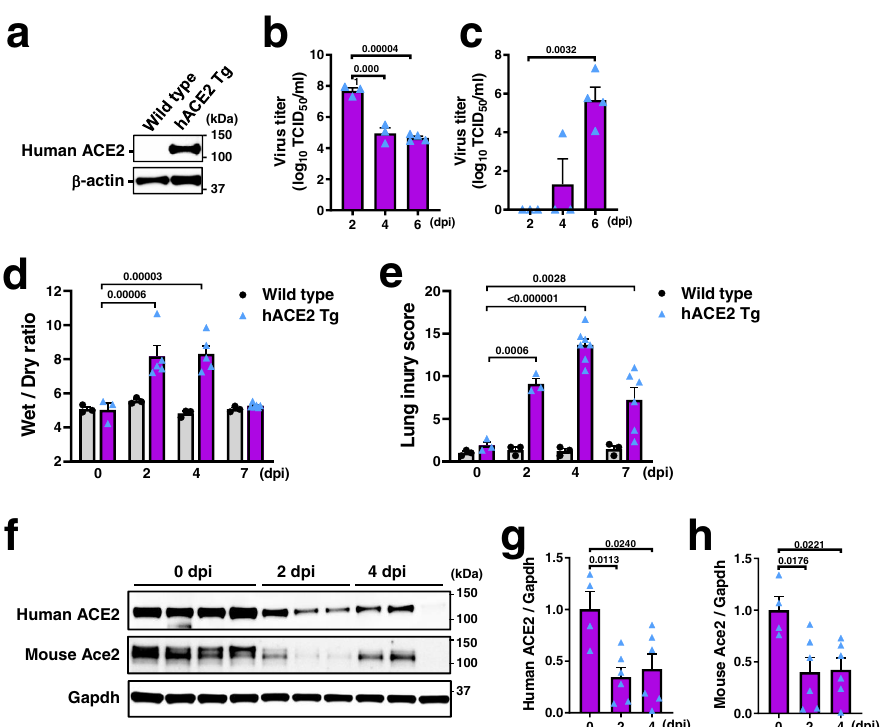
Fig. 5 SARS-CoV-2-induced lung injury and ACE2 downregulation in hACE2 Tg mice. a Western blot of human ACE2 protein in the lung lysates of uninfected hACE2 Tg mouse expressing human ACE2 under CAG promoter. b – c Virus titers (TCID 50 ) in the lysates of lung ( b ) and brain ( c ) prepared from hACE2 Tg mice intratracheally (i.t.) infected with SARS-CoV-2 (2 × 10 3 TCID 50 ) at 2 dpi ( n = 3), 4 dpi ( n = 3), and 6 dpi ( n = 4). dpi; days post infection. d Lung edema of wild-type and hACE2 Tg mice after SARS-CoV-2 infection. Wet/dry ratio of lung weight of wild type mice ( n = 3 each for 0, 2, 4, and 7 dpi) and hACE2 Tg mice ( n = 3 for 0 dpi, n = 5 each for 2 and 4 dpi, n = 6 for 7 dpi). e Lung injury score of wild-type and hACE2 Tg mice after SARS-CoV-2 infection. n = 7 for hACE2 Tg mice at 4 dpi, n = 6 for hACE2 Tg mice at 6 dpi, and n = 3 for other experimental groups. f – h Protein expression of human ACE2 and mouse Ace2 in the lungs of SARS-CoV-2-infected hACE2 Tg mice. Representative Western blots are shown ( f ). Human ACE2 ( g ) and mouse Ace2 ( h ) were normalized with Gapdh ( n = 4 mice for 2 dpi, n = 6 each for 2 and 4 dpi). All values are means ± SEM. One-way ANOVA with Sidak ’ s multiple comparisons test ( b – e , g , h ). Numbers above square brackets show P values. Independent experiments were performed one time ( b , c ) or two times ( a , d – h ), and consistent results were